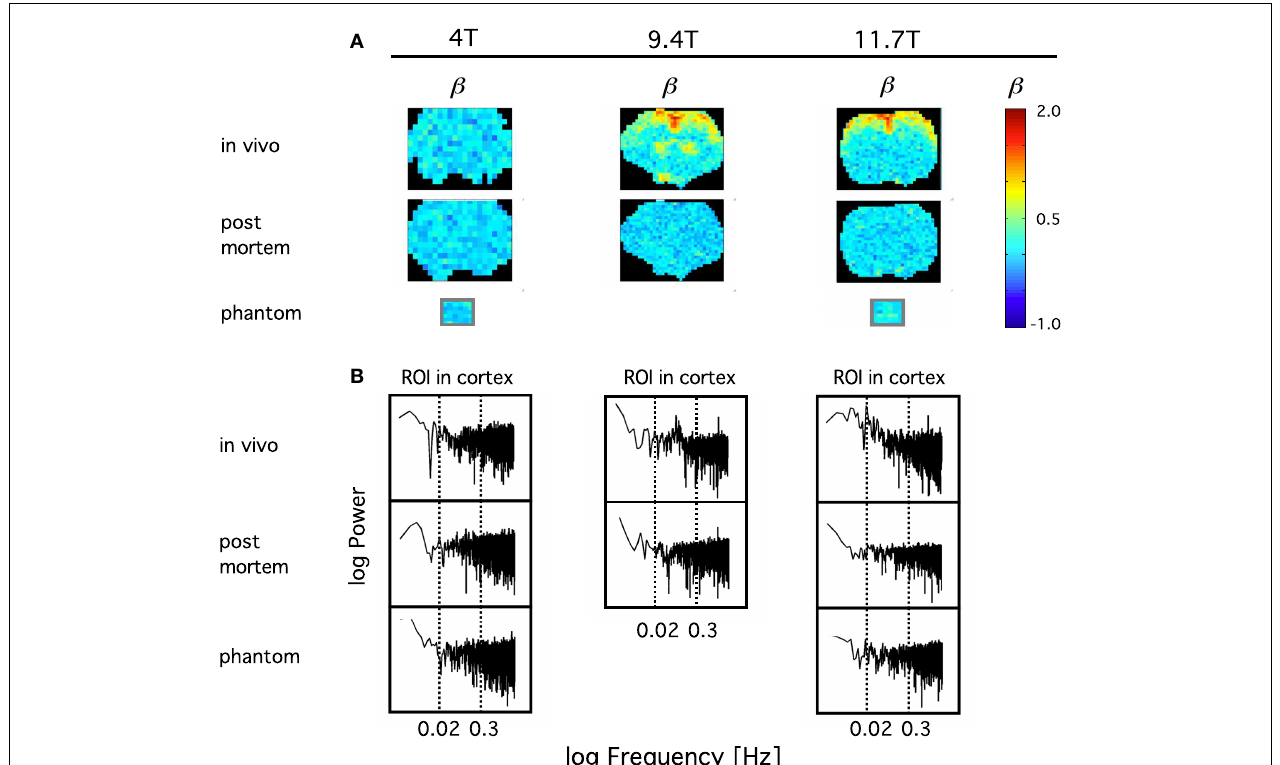
(from 0 to 1). Hence voxel data with β > 1 indicating the presence of fBm type fluctuations are displayed saturated (in red). β maps for water phantoms placed in the isocenter are also shown for comparison. Note, that the fractal pattern of internal structuring of the spontaneous BOLD signal cannot be captured at adequate definition at 4T as opposed to 11.7T, where the rate of scale-free rise of power toward low frequencies are thus the highest at about the same region of interest (ROI) located in the brain cortex.This dependence translates into an articulate in vivo topology with increasing B 0 . Also note that in vivo 4T cannot yield a clear topology of β when compared to post mortem , and that the well defined topology achieved at higher fields vanished post mortem indicating the link between β and the underlying